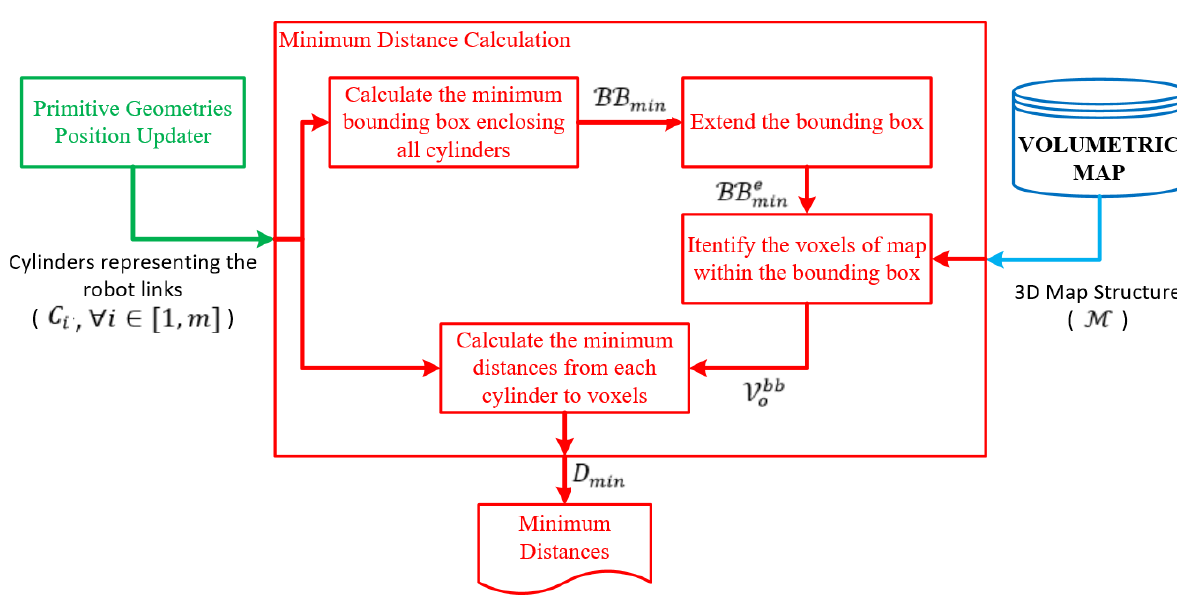
Figure 8. Minimum distance calculation.